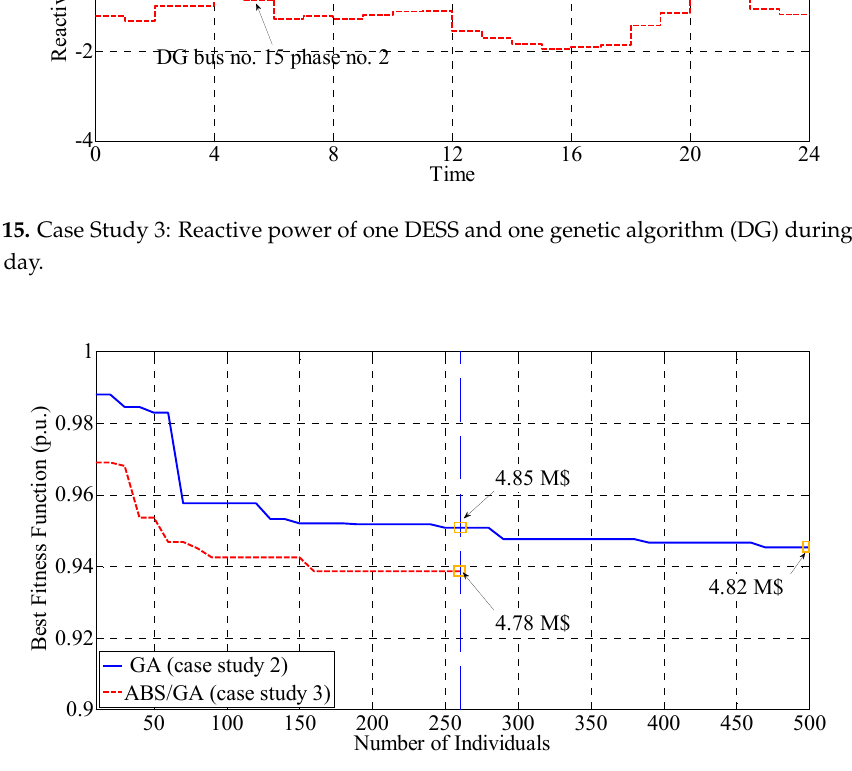
Figure 16. Comparison of the GA fitness function values in both case studies.